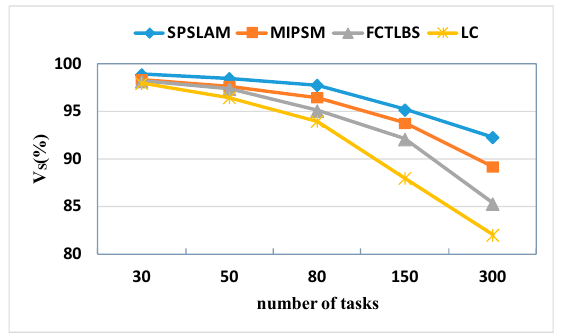
Figure 4. Success rate of tasks under different task numbers.